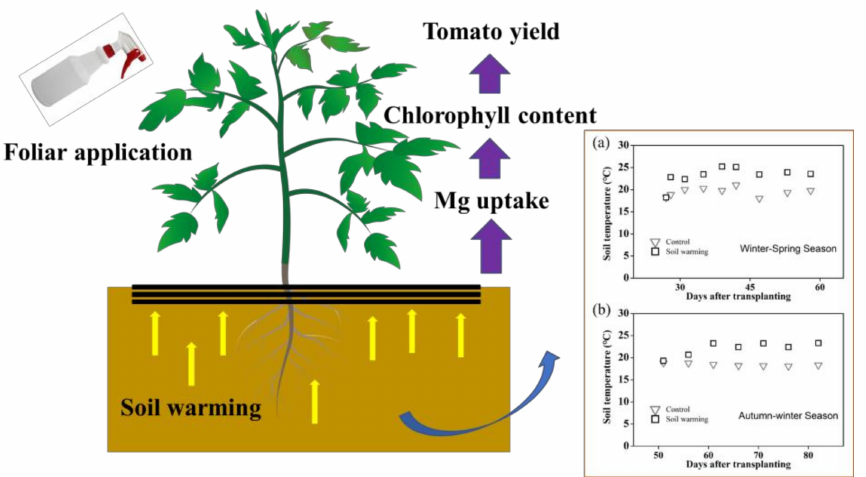
Figure 3. The combined strategy of foliar spray and soil warming could increase Mg content and yield of tomato by directly increasing the Mg uptake by leaves and indirectly enhancing soil Mg availability caused by high soil temperature,